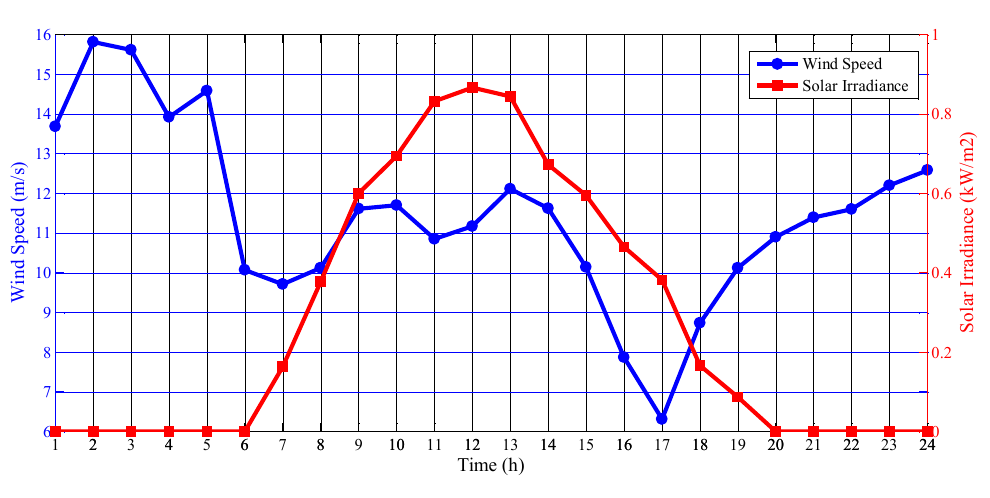
Figure 8. Real-Time Wholesale Electricity Market (RT WEM) prices for reduced scenarios. 3.2. Analysis of Simulation Results To examine the effectiveness of the suggested algorithm, two case studies are implemented, and their outputs are compared with one another. The considered model stated by Equations (52)–(77) is a mixed-integer linear programming problem, which is solved by the CPLEX solver in the General Algebraic Modeling System software. The optimality gap of the optimization model is set to 0.0, and the running time of it is less than 100 s. The personal computer used for simulation has an Intel Core i7-4510U CPU (2.60-GHz) and 8 GB of RAM. 3.2.1. Case Study 1: Considering the Game-Theoretic Approach In this case, existing players of the SDN are able to optimize their objective functions independently through the proposed Stackelberg game-based framework. The exchanged energy of the DSO with available markets in the DA stage is displayed in Figure 9.